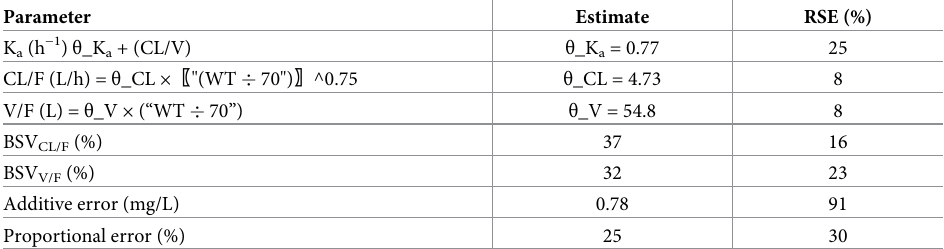
Table 2. Parameter values for modelled linezolid pharmacokinetics in children with MDR-TB ( n = 48).